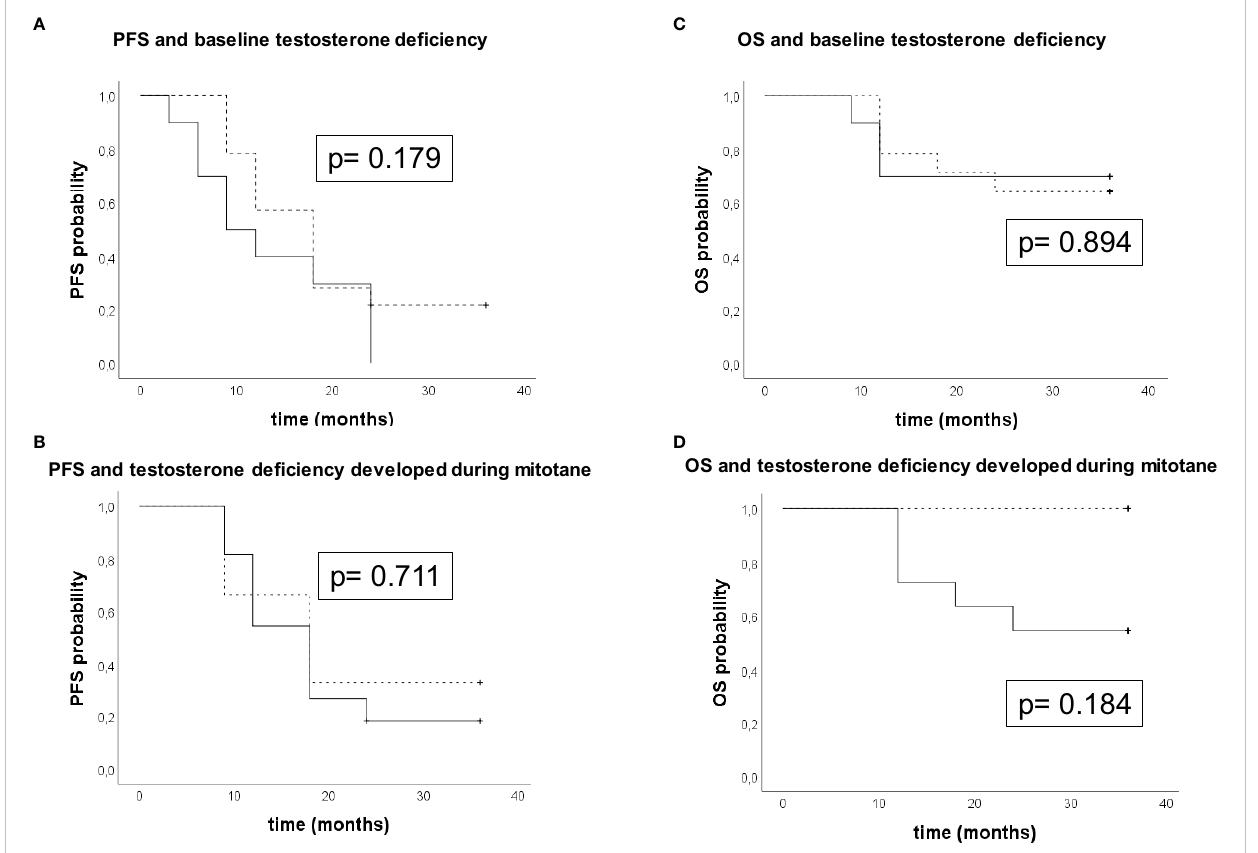
FIGURE 2 Impact of testosterone de fi ciency on PFS and OS. (A) Baseline testosterone de fi ciency and PFS: cases of metastasis in men with baseline testosterone de fi ciency (10/10) vs. baseline eugonadal men (11/14); (B) testosterone de fi ciency developed during treatment and PFS: cases of metastasis in men with developed testosterone de fi ciency (9/11) vs. eugonadal men also during treatment (2/3); (C) baseline testosterone de fi ciency and OS: cases of death in men with baseline testosterone de fi ciency (3/10) vs. baseline eugonadal men (5/14); (D) testosterone de fi ciency developed during treatment and OS: cases of death in men with developed testosterone de fi ciency (5/11) vs. eugonadal men also during treatment (0/3). Comparison was performed with chi-square test. Continuous line: testosterone de fi ciency patients; dotted line: eugonadal men. On the horizontal axis, the months passed. PFS, progression-free survival (as months without metastasis); OS, overall survival (as months without